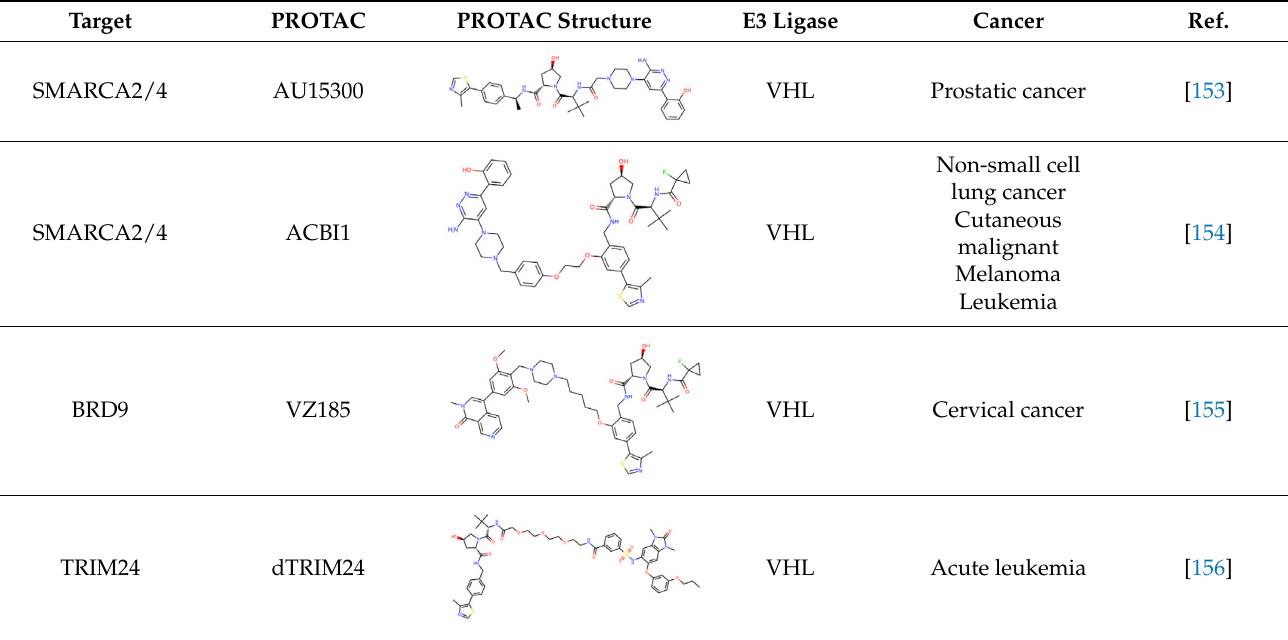
Table 4. PROTACs for Chromatin remodeling targets